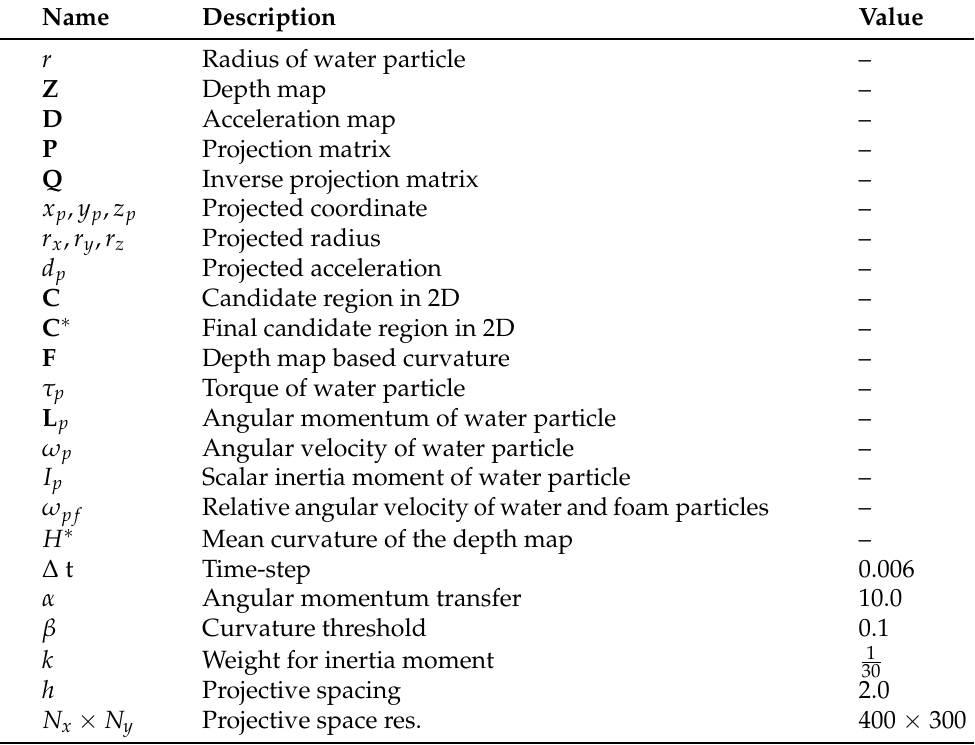
Table 1. Simulation variables and